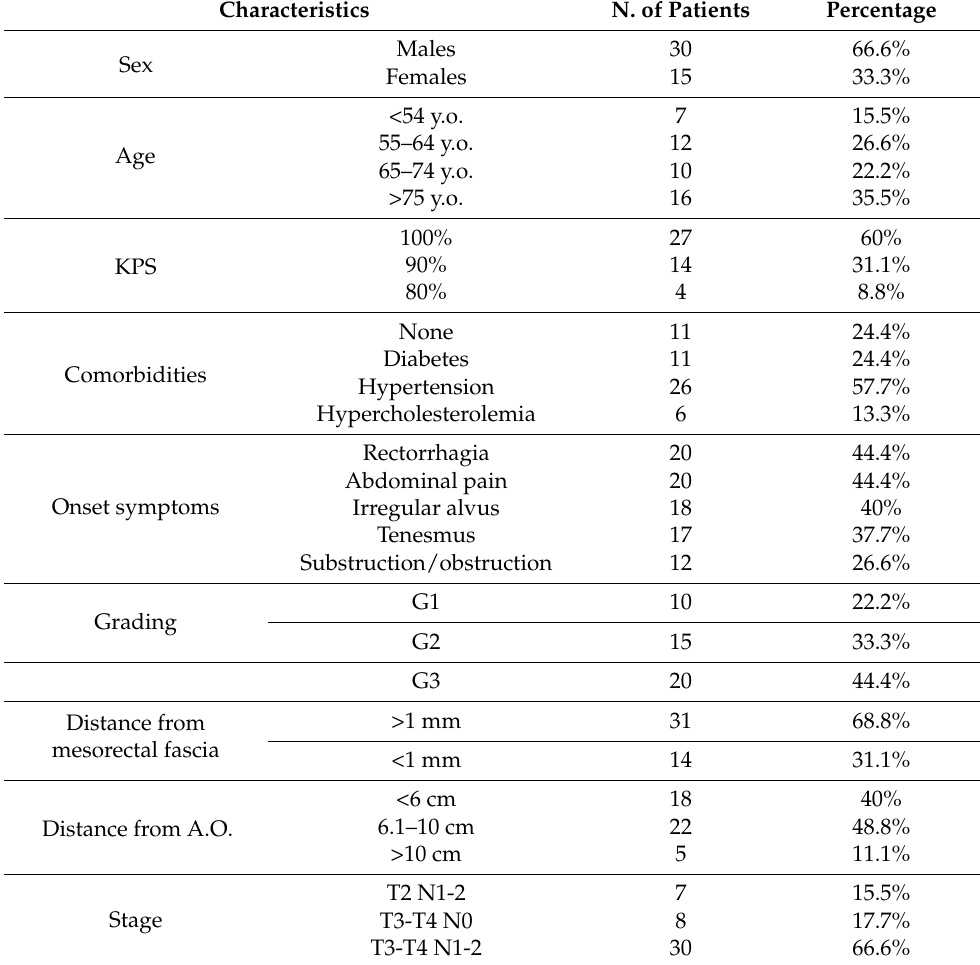
Table 1. Patients’ characteristics. Characteristics N. of